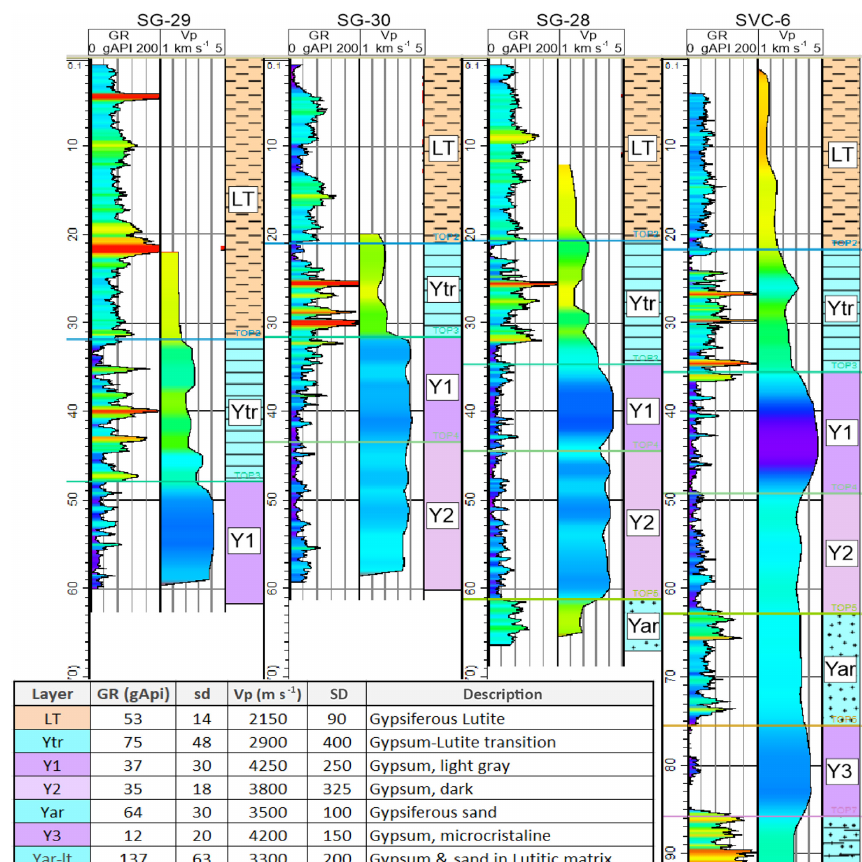
Figure 6. Drill holes in the target area with the borehole geophysical logs used in this study. This reveals the correlation between the rock samples, its description and the values of the physical properties (gamma ray, GR; sonic logs, Vp). The top part of the figure reveals the logged data with the correlation between the available boreholes. The bottom table defines the summary criterion used for the interpretation of the different lithologies. The Vp value should be representative of the corresponding lithologies. This criterion is used later in the text to differentiate between the different lithologies in the velocity cube obtained from the tomographic inversion. The left column identifies the location of the boreholes within the acquisition geometry of the seismic survey with the outcropping geology of the target